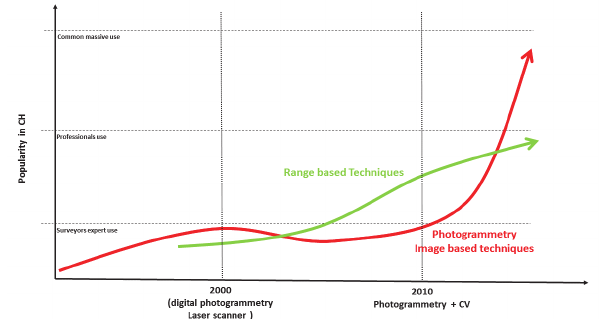
Figure 12: Image base techniques vs Range based techniques, the trend in popularity and use in the field of